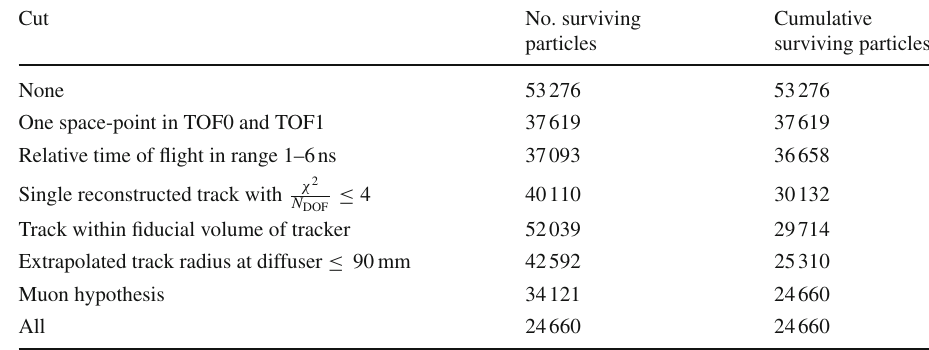
Cut No. surviving